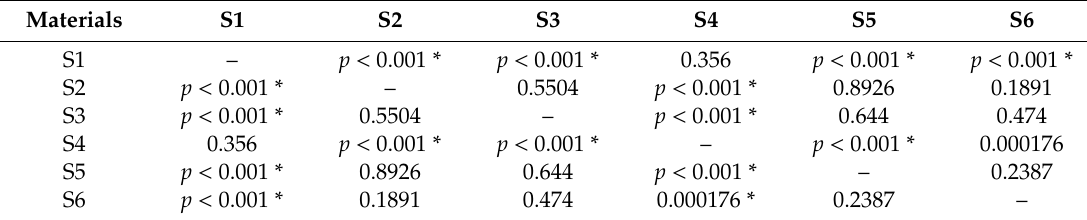
Table 9. Di ff erences in ∆ E after 168 h immersion in soy sauce.